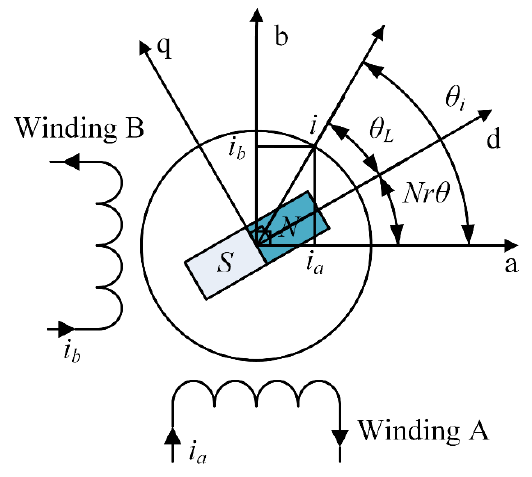
Figure 1. Model of a two-phase bipolar hybrid stepper motor.